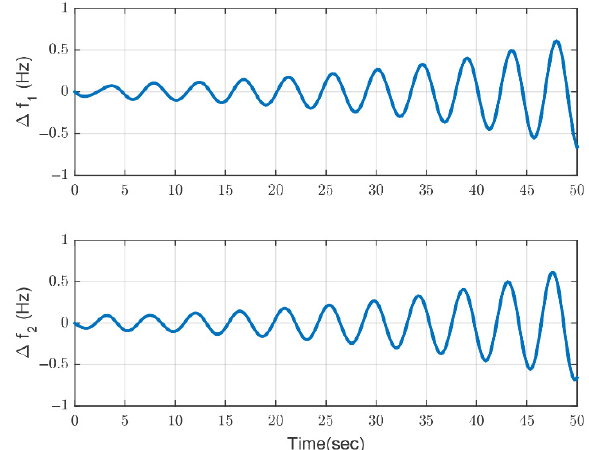
Figure 4. Frequency deviations in an LFC system without external control input. The parameters ∆ P vi and are considered as 0.12 p.u. and − 0.03 p.u., respectively. Furthermore, design parameters ξ 1 and ξ 2 are chosen as 0.47.